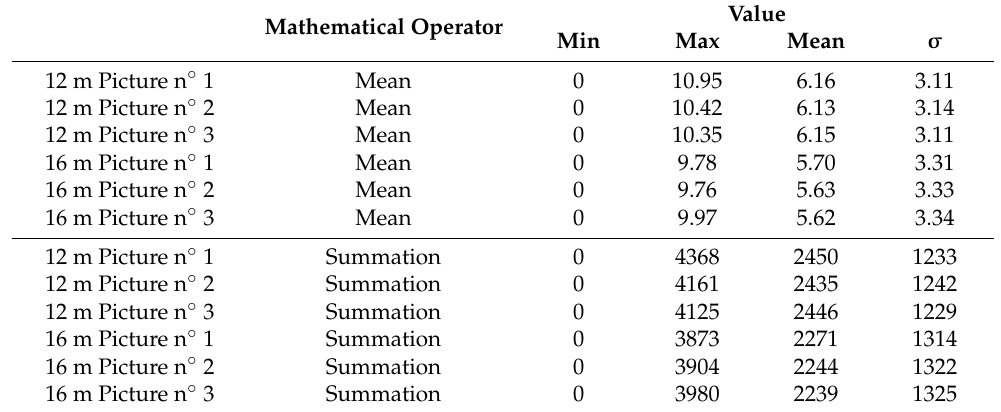
Figure 5. Results of selection of best aggregation technique using the example of results with the first repetition at 12 m. ( a ) VSI; ( b ) aggregation technique = Maximum; ( c ) aggregation technique = Mean; ( d ) aggregation technique = Summation; ( e ) aggregation technique = Minimum; ( f ) aggrega ‐ tion technique = Median. The crops in the images from top to bottom lines are ervil, chickpea, and lentil.